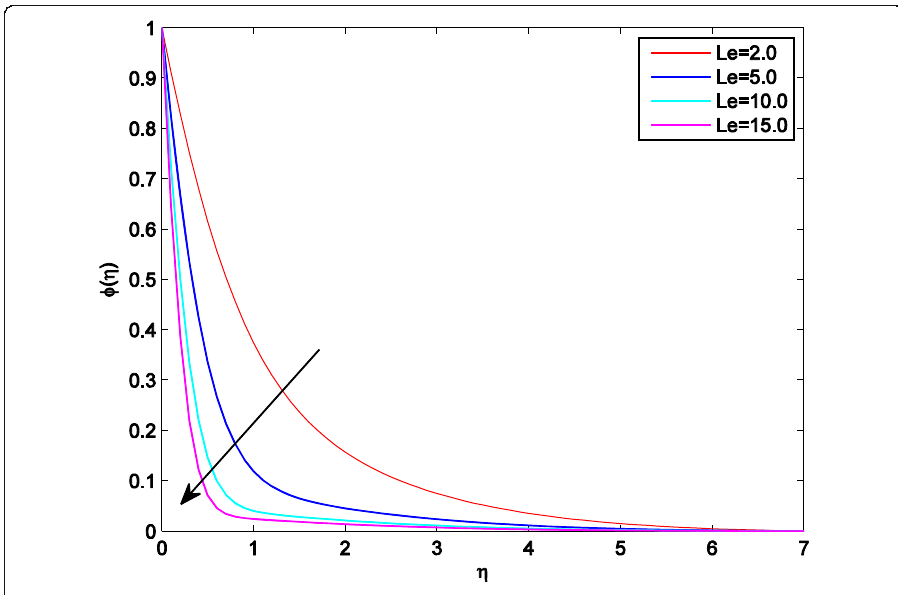
Fig. 19 Concentration graph for various value of Le